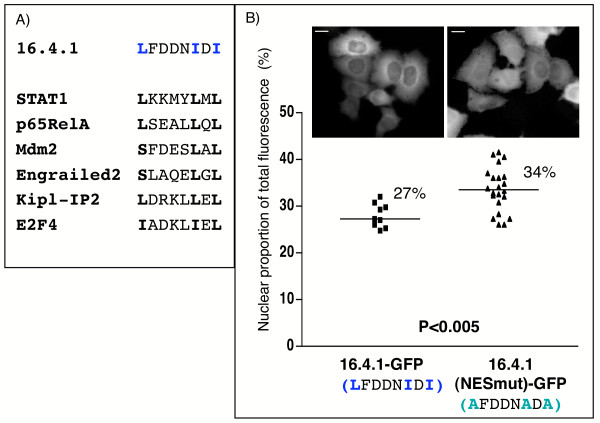
Influence of the nuclear export signal on cytoplasmic localization of 16.4.1. (A) Sequences identified in 16.4.1 and in proteins contained in a database of experimentally verified NES by a common weight matrix. Protein sequences in NESbase version 1 [36] were analysed with a collection of 7 weight matrices. These identified 48 of 75 NES in their native protein context at default threshold (0.84). Analysis of the 16.4.1 sequence with reduced threshold settings (0.74) yielded a single match with matrix M5 but not with any other matrix. This match identified the 16.4.1 core NES (shown at top). Sequences in proteins of the NES database identified by M5 at default threshold are shown below. All sequence matches map to experimentally verified NES. (B) To assess functionality of the novel 16.4.1 NES in the context of the full length protein, a 16.4.1 mutant was generated in which L92, I97 and I99 were replaced by alanine residues. HeLa cells were transfected with plasmids for expression of GFP fusion proteins containing wild type (16.4.1-GFP) or mutated (16.4.1(NESmut)-GFP) 16.4.1 and subcellular distribution of GFP fusion proteins were evaluated by quantitative fluorescence microscopy. Cells expressing 16.4.1(NESmut)-GFP showed a significantly higher nuclear proportion of fluorescence (34%) than cells expressing wild type 16.4.1-GFP (27%). This effect was significant (p < 0.005). Scale bars: 10 μm.